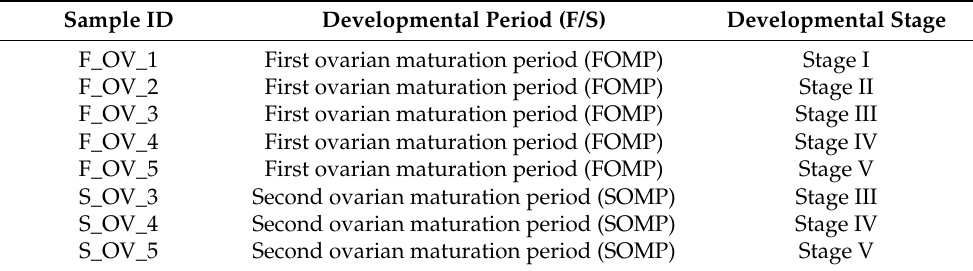
Table 1. Information related to ovary (OV) tissue